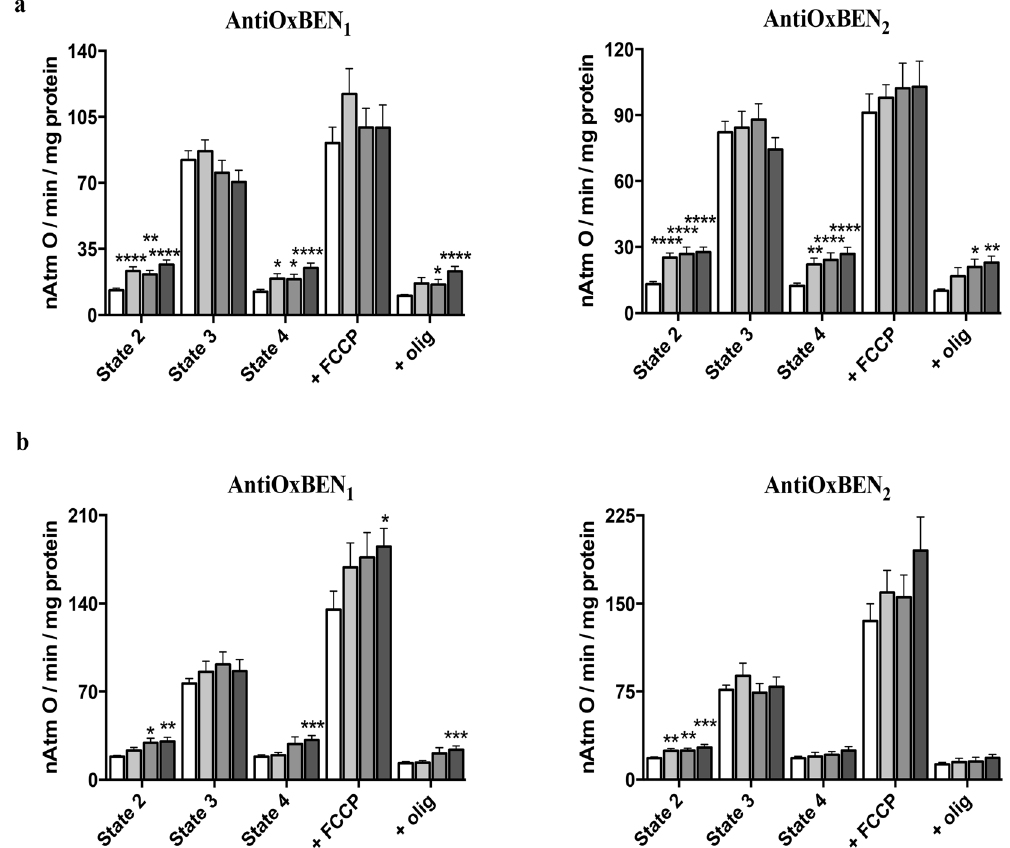
Figure 6. Effect of AntiOxBENs on RLM respiration supported by ( a ) 10 mM glutamate + 5 mM malate or ( b ) 5 mM succinate. The white bars refer to the control, while grey bars refer to the experiments where RLM were pre-incubated with AntiOxBENs (2.5 μ M – light grey; 5 μ M – grey; and 10 μ M – dark grey). The presented results are means ± SEM of seven independent experiments. The statistical significance relative to the different respiratory rates/states was determined using Student’s two tailed t-test ( * P < 0.05, ** P < 0.01, *** P < 0.0005, **** P < 0.0001).